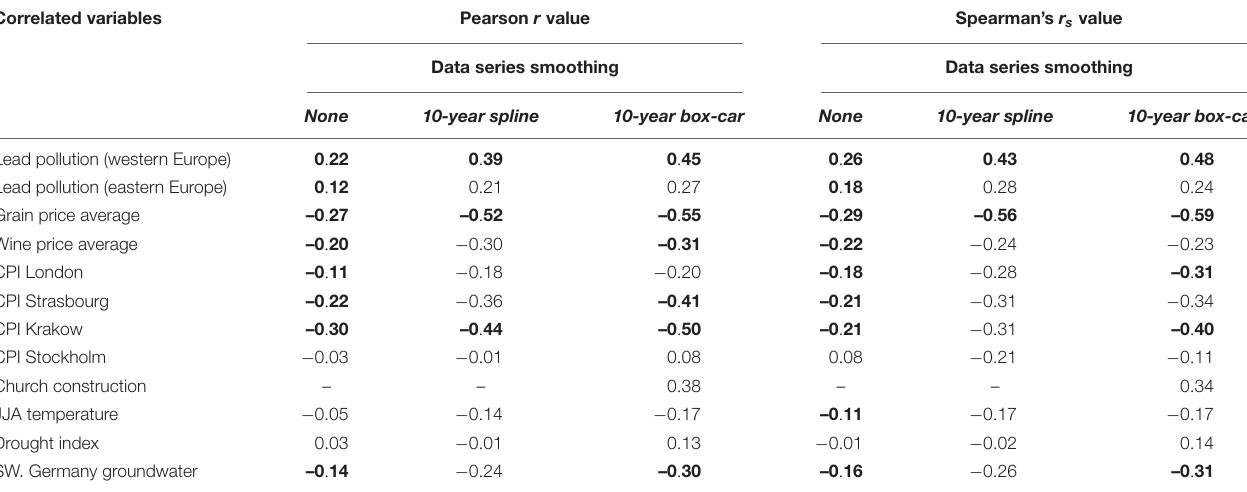
TABLE 6 | Correlation between 300-year filtered and standardized subsets for comparison with the entire felling date dataset. Correlated